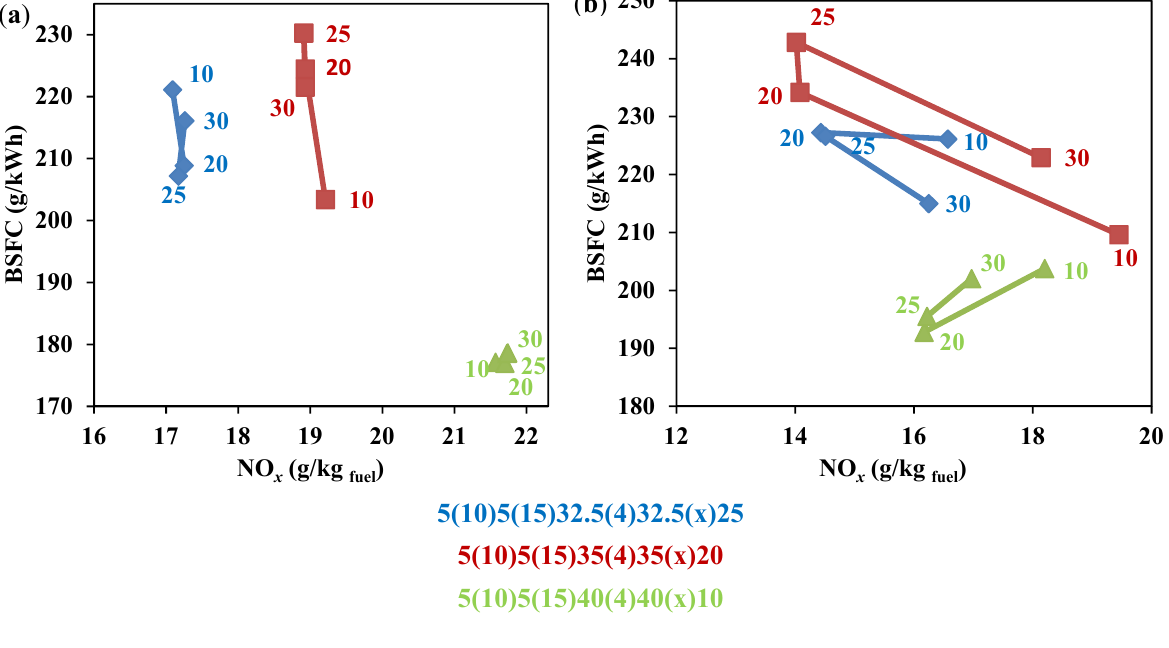
Figure 10 . BSFC for the investigated cases and the EGR values: ( a ) 10% and ( b )